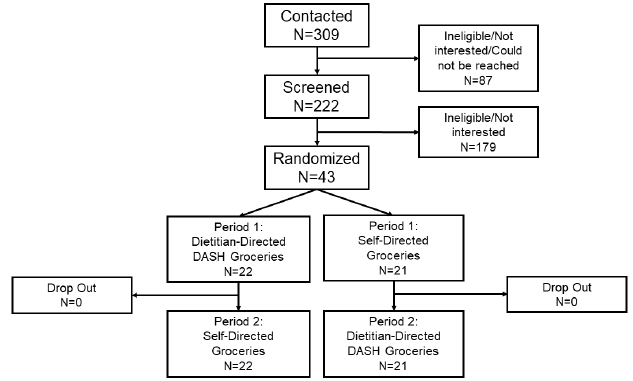
Figure 1. CONSORT